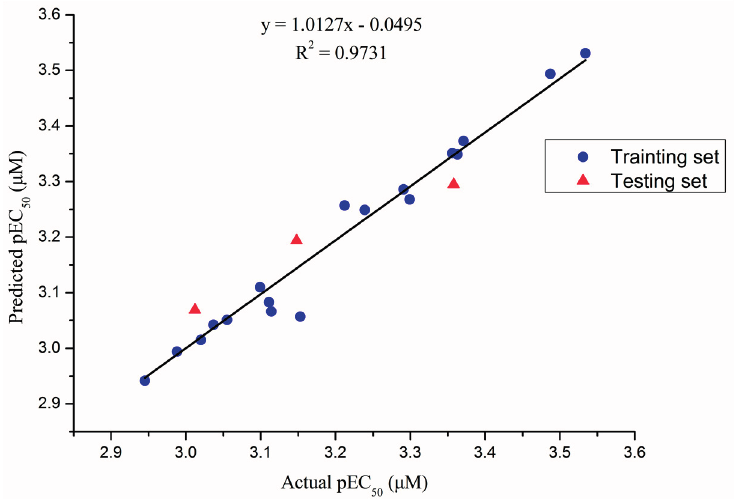
Figure 1. Plot of actual predicted activities for training set and test set based on the comparative molecular field analysis (CoMFA)